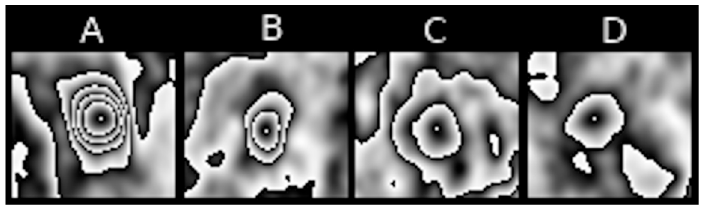
Figure 4. Examples of [18F] FDG uptake contour nestings within various types of pulmonary nodules: